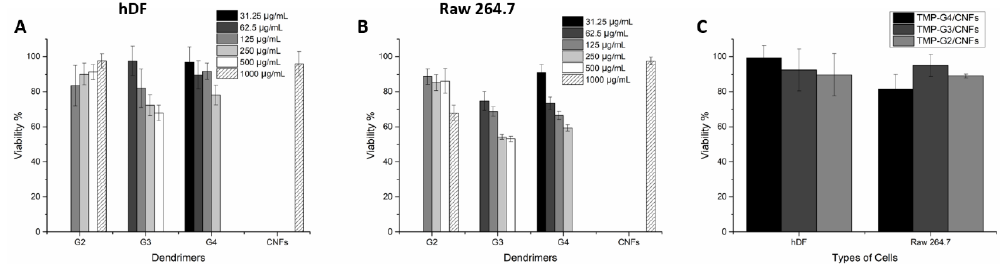
Figure 6. AlamarBlue assay for the cytotoxicity evaluation of ( A ) the cationic dendrimers towards human dermal fibroblast (hDF), ( B ) the cationic dendrimers towards Raw 264.7 and ( C ) the hybrid hydrogels towards both hDF and Raw 264.7 after incubation for 24 h.